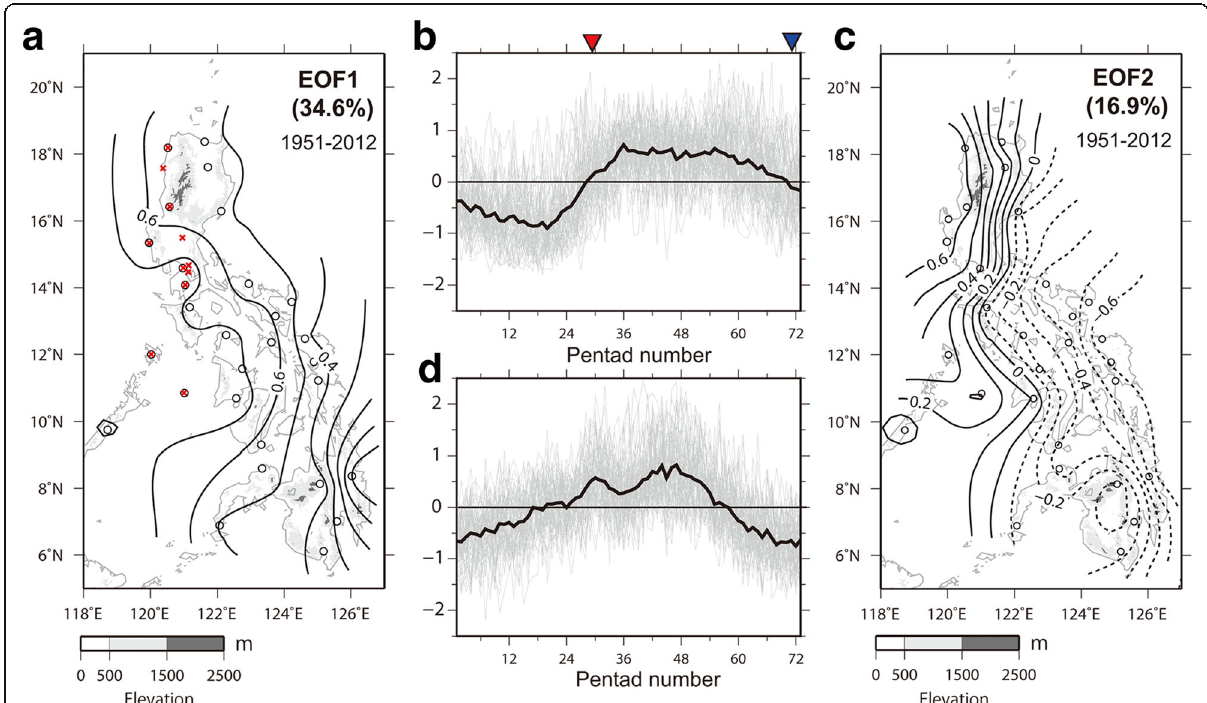
Fig. 1 Factor loadings and the time coefficients of EOF1 and EOF2. The contour interval is 0.1 in a and c . The open circles in a and c indicate the observation stations used for the EOF analysis. The red cross marks in a indicate the observation stations used in Fig. 4. The thick and thin lines in b and d indicate the mean time coefficients averaged for 1951 – 2012 and the time coefficients in each year, respectively. The red and blue inverse triangles in b denote the first pentad (the 29th and 71st pentads) when the sign of the mean time coefficients for the EOF1